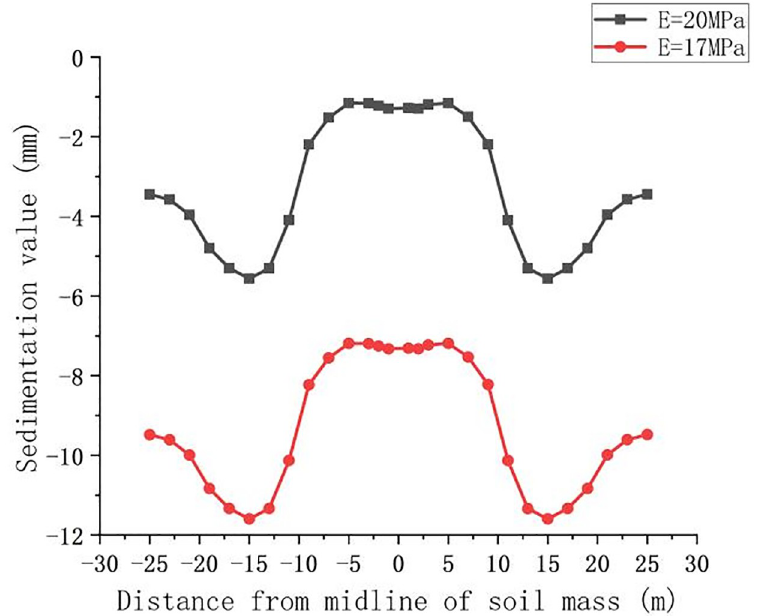
Fig 20. Deformation curve caused by the change in the elastic modulus.